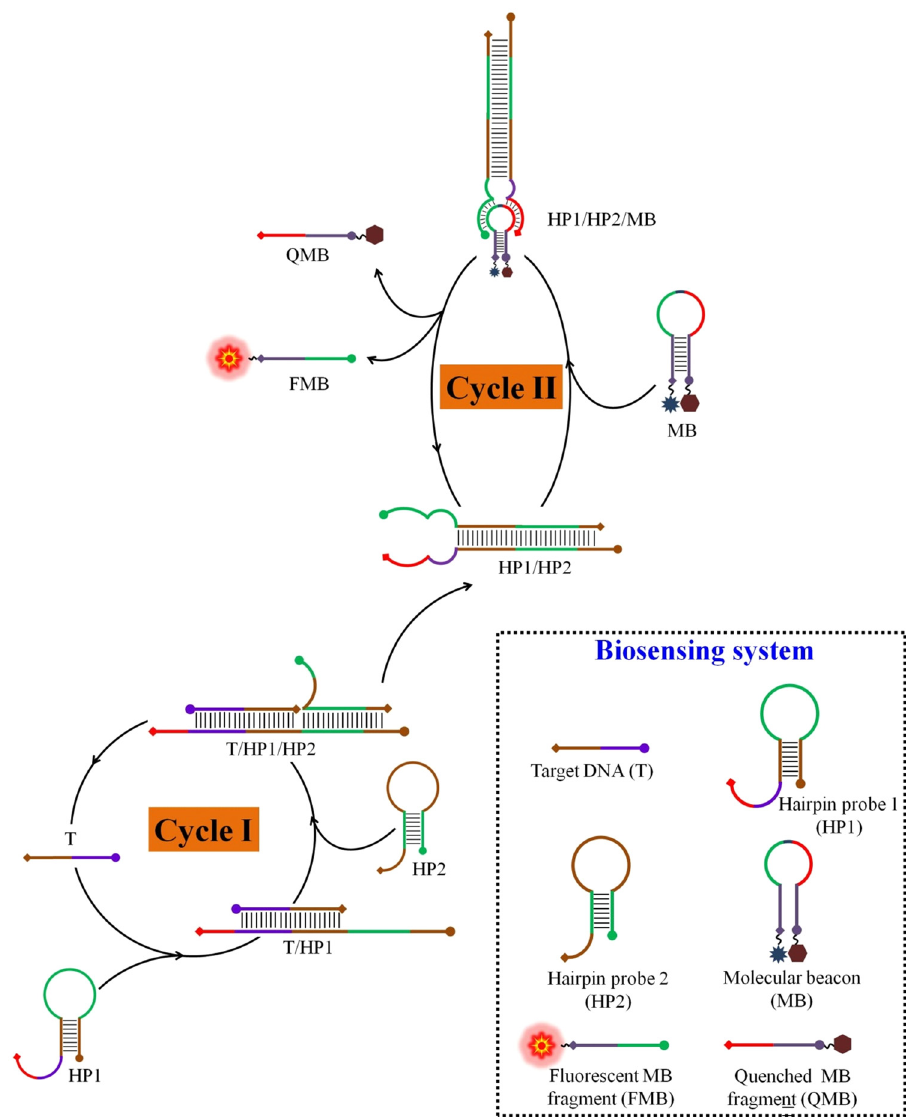
Figure 1: Schematic of the CHA – DNAzyme - assisted dual - mode ampli fi cation system for fl uorescent detection of target